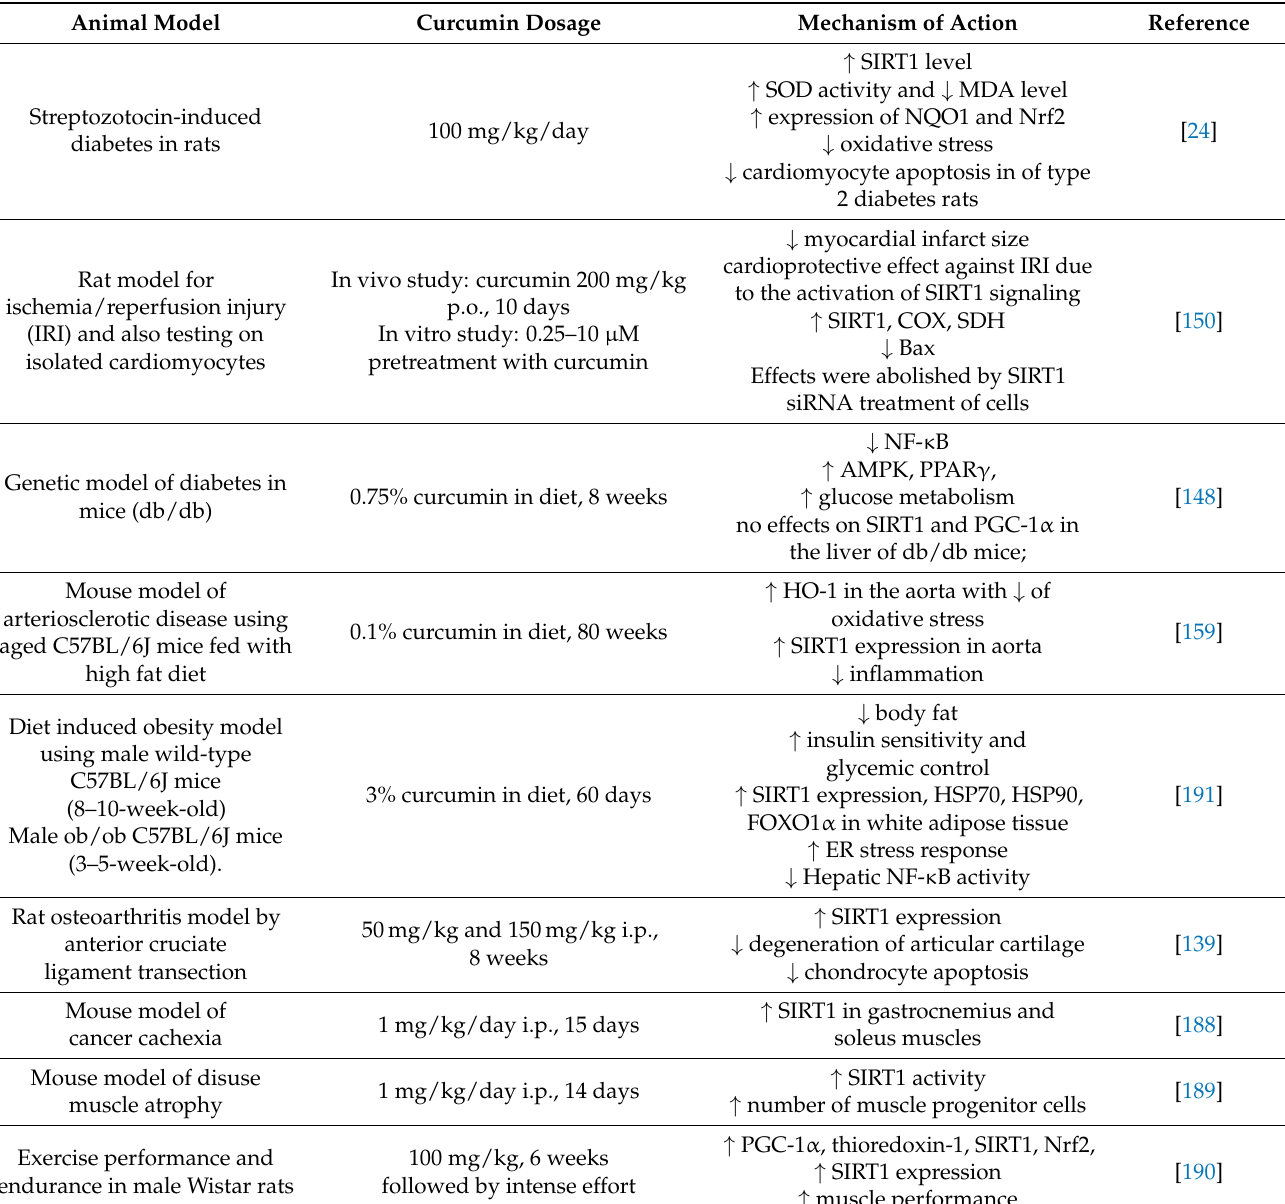
Table 1. Preclinical results regarding the effects induced by curcumin in animal models, through modulation of sirtuin activity and